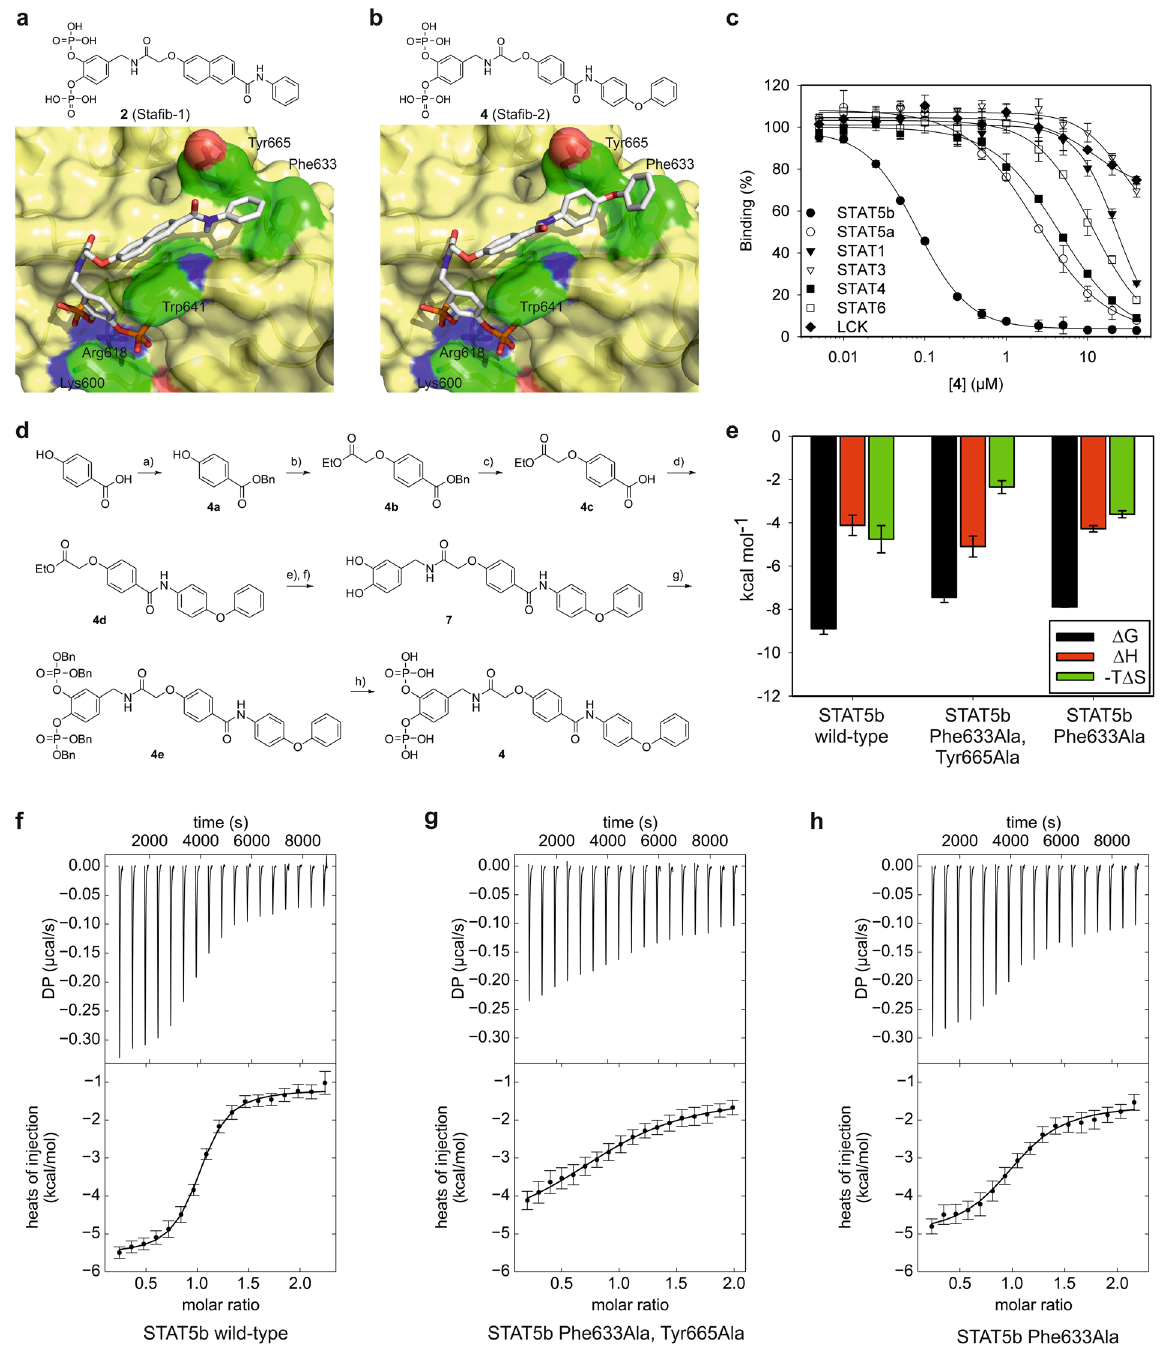
Figure 2. Synthesis and functional characterization of Stafib-2 ( 4 ). ( a ) Docking pose of Stafib-1 ( 2 ) 15 . ( b ) Docking pose of 4 predicted by AutoDock Vina. ( c ) Specificity profile of 4 . Error bars represent standard deviations from three independent experiments. ( d ) Synthesis of 4 . ( a ) BnBr, KHCO 3 , DMF, 4 h, 87%; ( b ) ethyl bromoacetate, K 2 CO 3 , DMF, 1 h, 99%; c) Pd/C, H 2 , EtOH, 1 h, 99%; d) 4-phenoxyaniline, EDC, HOBt, DMF, 16 h, 85%; ( e ) 1 M NaOH, THF, 1 h; ( f ) 4-(aminomethyl)benzene-1,2-diol, EDC, HOBt, TEA, DMF, 16 h, 60% over 2 steps; ( g ) dibenzylphosphite, CCl 4 , DIEA, DMAP, 1 h, 78%; ( h ) Pd/C, H 2 , EtOH, 1 h, 94%. ( e ) Thermodynamic parameters extracted from ITC experiments with STAT5b wild-type (n = 3), STAT5b Phe633Ala, Tyr665Ala (n = 3), and STAT5b Phe633Ala (n = 2). Error bars represent standard deviations (s.d.). ( f ) Representative ITC data for binding between 4 and wild-type STAT5b, ( g ) STAT5b Phe633Ala, Tyr665Ala, and h) STAT5b